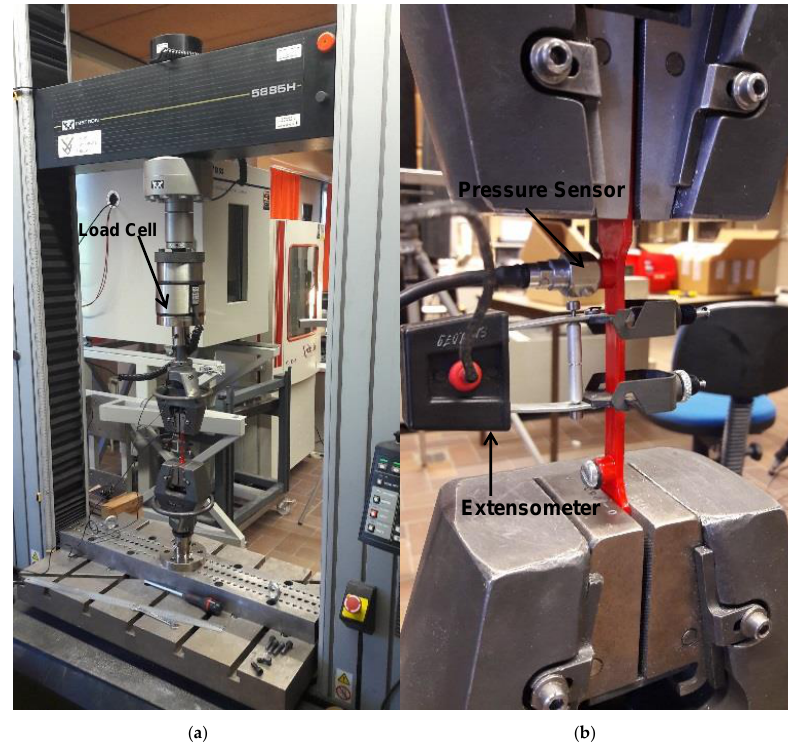
Figure 7. ( a ) Tensile test setup ( b ) Detailed view of the two strain measurements: extensometer and pressure sensor connected to integrated